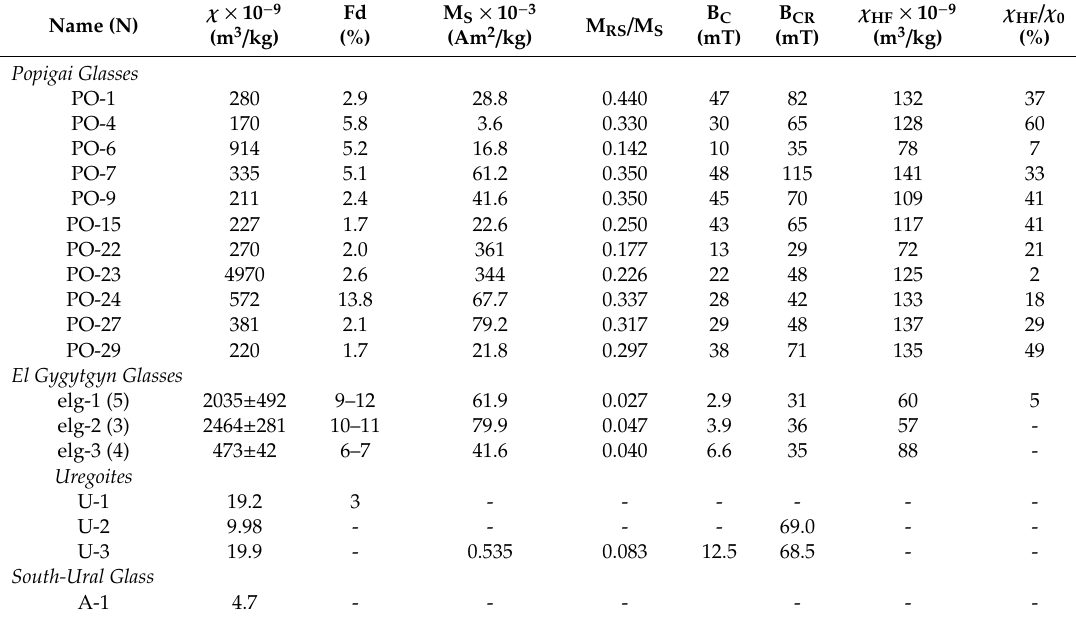
Table 2. Main magnetic properties of impact glasses: new cases from Siberia. χ is low-field magnetic susceptibility; Fd is frequency dependence of χ ; χ HF is high-field magnetic susceptibility; M S is saturation magnetization; M RS is saturation remnant magnetization; B C is coercivity, B CR is remanent coercivity; N is the number of sub-samples measured; for Popigai, only samples with hysteresis data are